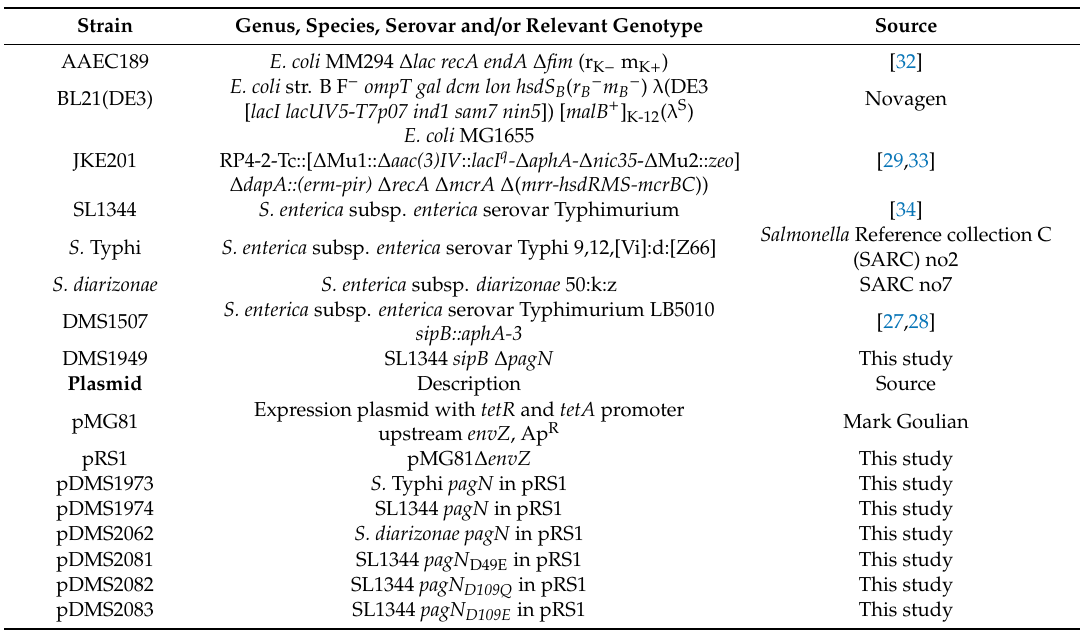
Table 1. Strains and